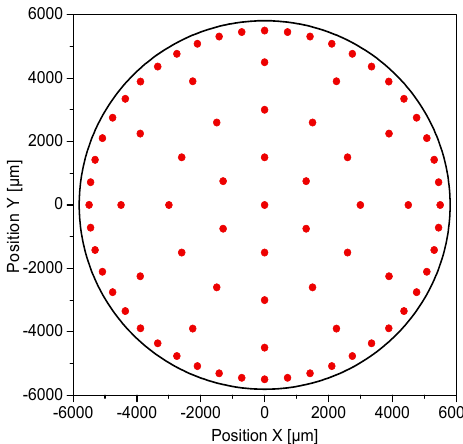
Figure 2. Relative position of the indentation locations throughout the flat face of the cylindrical tablets.